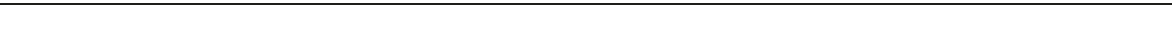
Fig. 5 Low stromal PTEN is observed in normal breast tissue and predicts outcome in a HER2-positive breast cancer patient cohort. a Representative PTEN immunohistochemistry and quanti fi cation (mean of 4 – 10 representative fi elds/sample) in normal breast tissue isolated from women who underwent reduction mammoplasty ( n = 99). Scale bars = 20 μ m. b Representative PTEN immunohistochemistry in breast tumor samples isolated from women with HER2-positive disease treated with radiation therapy. Zoomed images show adjacent normal ductal tissue with either high or low stromal PTEN (high, n = 22 patients; low, PTEN n = 21 patients). Scale bars: top images = 1 mm; bottom images = 20 μ m. c Kaplan – Meier analysis exhibiting recurrence